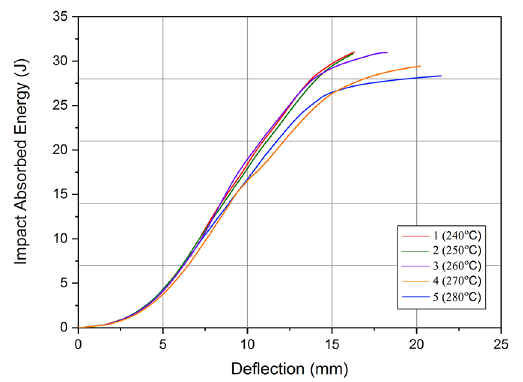
Figure 8. Absorbed energy on drop-weight test. (Bibliographic Source: Author.)